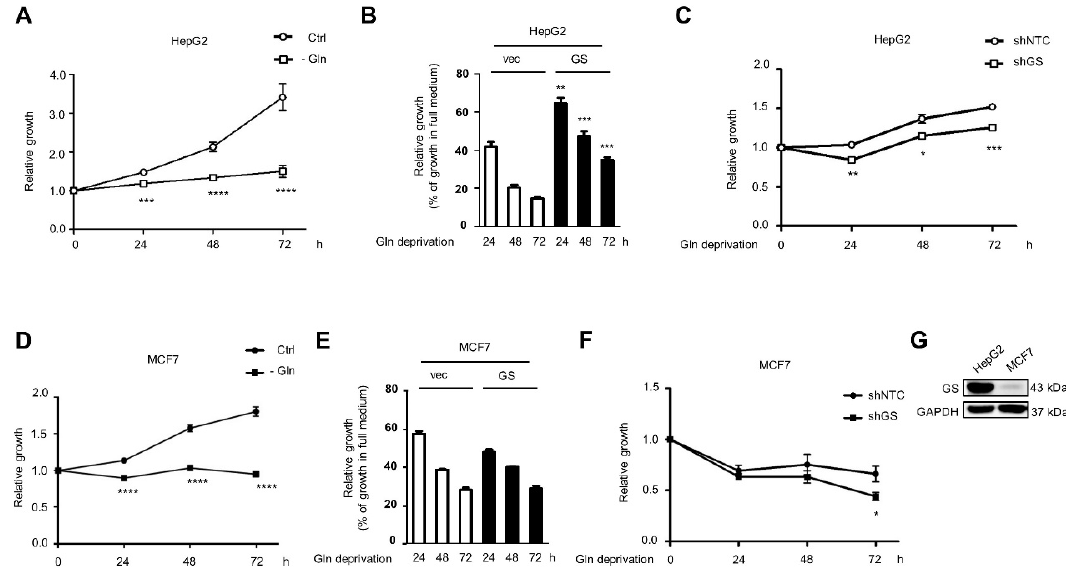
Figure 6. GS supports cell survival under glutamine deprivation. ( A , D ) Cell growth of HepG2 ( A ) and MCF7 ( D ) cells in full (Ctrl) and glutamine deprivation (-Gln) medium was measured by MTT assay and shown as the mean plus SEM. ( B , E ) HepG2 ( B ) and MCF7 ( E ) cells were stably transfected with vector control or pBabe-GS. Cell growth in full or glutamine (Gln) deprivation medium was measured by MTT assay. Relative growth in Gln deprivation medium (% of growth in full medium) was shown as the mean plus SEM. ( C , F ) HepG2 ( C ) and MCF7 ( F ) cells were stably transfected with non-targeting control or GS shRNA. Cell growth in Gln deprivation medium was measured by MTT assay and shown as the mean plus SEM. ( G ) Cell lysates of HepG2 and MCF7 cells were analyzed by Western blot with specified antibodies. * p < 0.05, ** p < 0.01, *** p < 0.001, and **** p < 0.0001 represent the statistical significance compared to full (Ctrl) medium ( A , D ), to vector-transfected control cells ( B , E ), or to non-targeting control shRNA-transfected control cells ( C , F ).